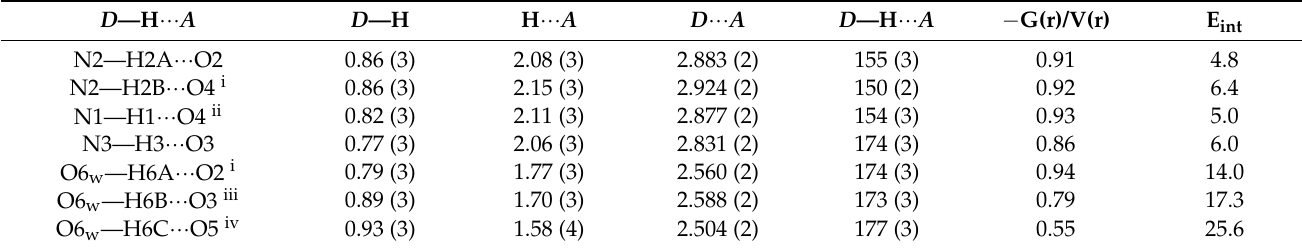
Table 4. Hydrogen-bond geometry (Å, ◦ ) and topological analysis for compound ( IV ). E int is reported in kcal/mol. For additional details concerning QTAIMS results see Tables S8–S10 in the Supporting Information.